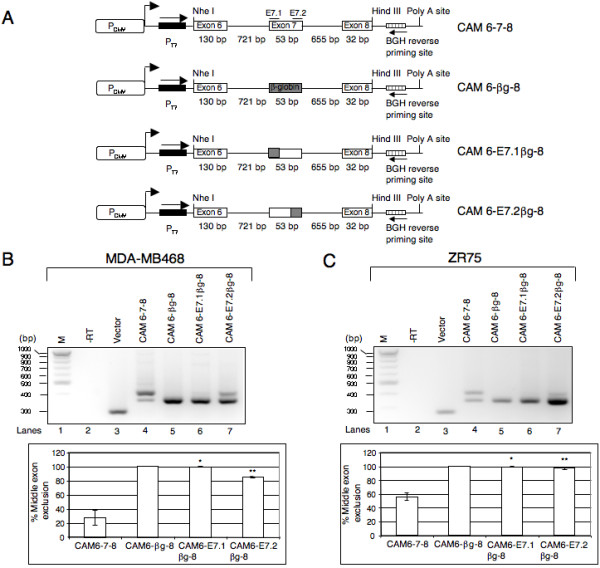
Identification of CEACAM1 regulatory sequences required for the splicing of exon 7. (A) Schematic representation of CEACAM1 minigene or chimeras cloned into pcDNA 3.1/Myc-His(-) C. Open or shaded boxes are exons and lines represent introns. The name of each minigene is indicated on right. The size of middle exon in all minigenes is identical to exon 7 of CEACAM1. In CAM 6-βg-8 the entire middle exon is replaced by 53 bp of •-globing exon 2. In minigenes CAM 6-E7.1•g-8 and CAM 6-E7.2•g-8, the first and the last 20 bp (E7.1 and E7.2 regions) of CEACAM1 exon 7 are replaced by •-globin exon 2 sequences. The forward (T7) and reverse priming sites (BGH) are indicated. (B and C) RT-PCR analysis of RNA derived from MDA-MB468 and ZR75 cells transiently transfected with indicated minigenes or empty vector. -RT represents omission of reverse transcriptase during cDNA synthesis. The data shown is representative of three independent experiments. Bar diagrams represent the mean ± SD of at least three independent experiments. *P < 0.001 and **P < 0.01 versus CAM 6-7-8.